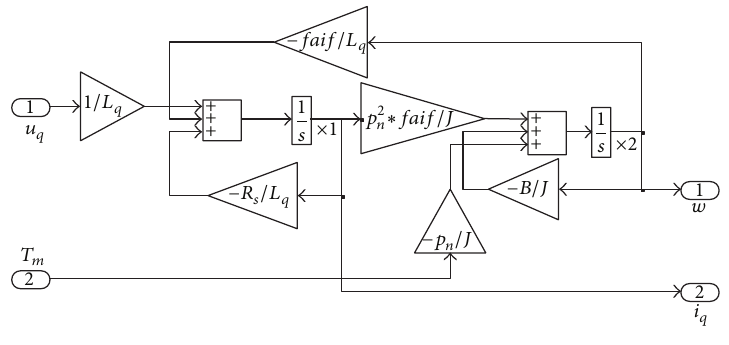
Figure 11: MATLAB/Simulink model of